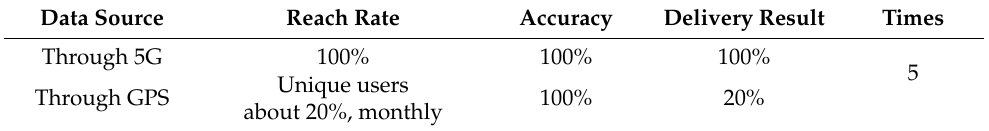
Table 18. Comparison of delivery effectiveness on anniversary consumers near a specific